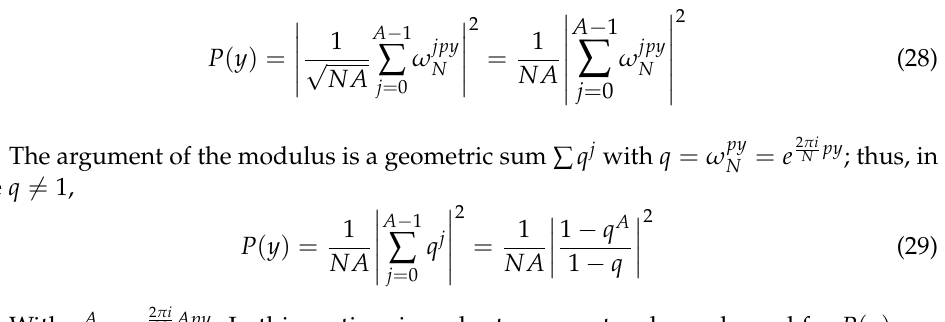
With d 2 sin x / dx 2 = − sin x ≤ 0 especially for x ∈ [ 0, π /2 ] , i.e., sin x is concave on x ∈ [ 0, π /2 ] . Thus, the secant between sin 0 = 0 and sin π (orange in Figure 18). However, this secant is given by g ( x ) = 2 x ≤ sinx for x ∈ [ 0, π /2 ] , i.e., with ϕ : = 2 x we get ϕ Thus, it is 2 π ≤ 2 sin ϕ this implies 2 ϕ for ϕ ∈ [ 0, π ] π 2